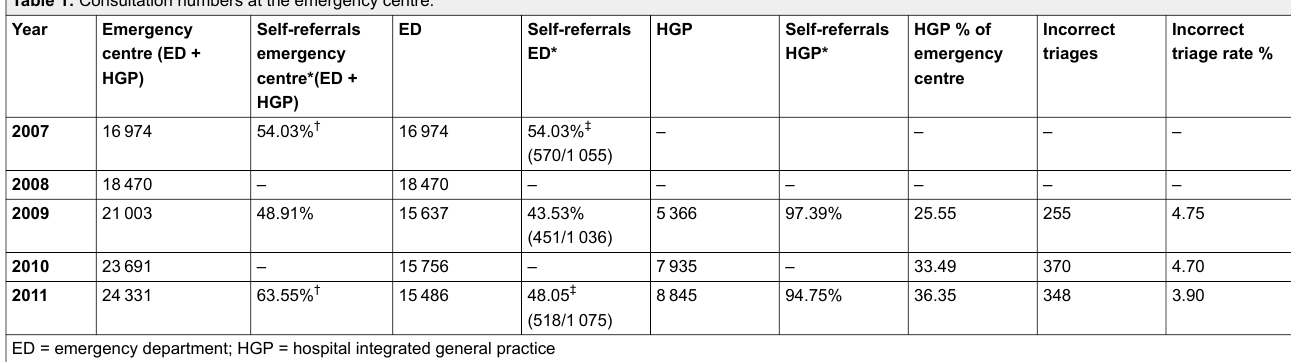
Table 1: Consultation numbers at the emergency